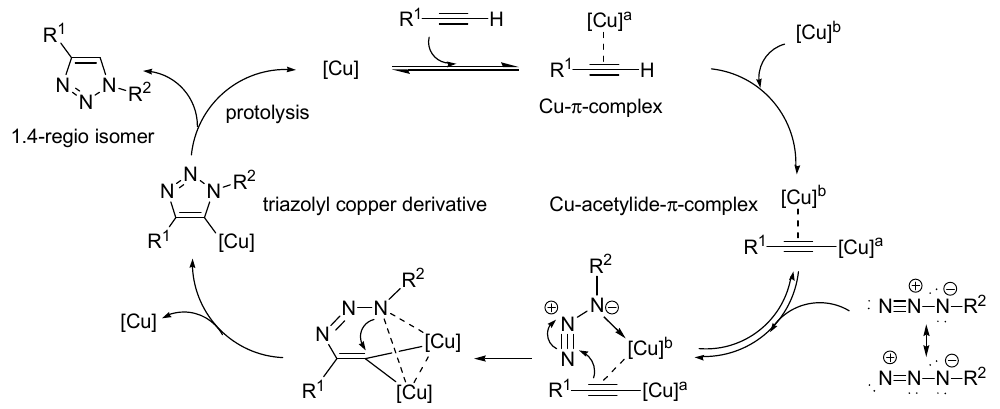
Scheme 2. Proposed mechanism of the copper-catalyzed 1,3-dipolar Huisgen cycloaddition (CuAAC) catalyzed by two copper atoms.